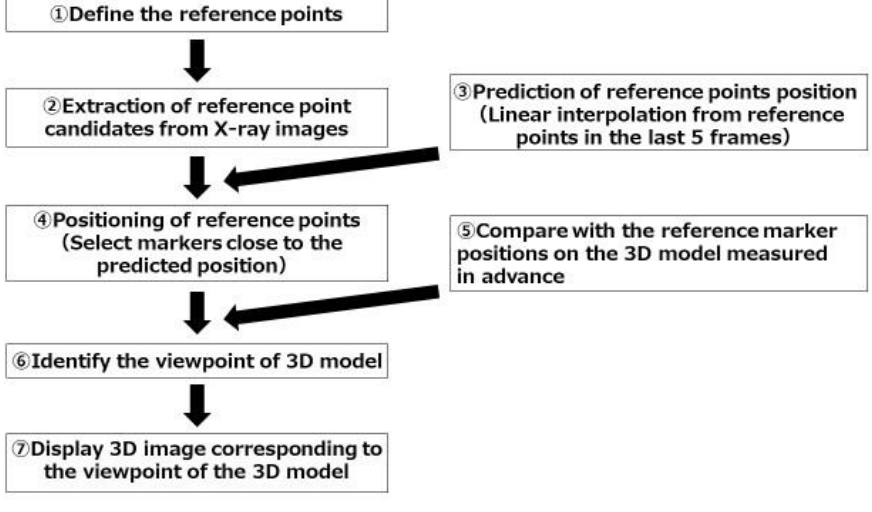
Figure 2. Algorithm of the 3D tracking. The algorithm of the tracking was designed to track pre-specified reference points. The numbers represent the steps in the text.